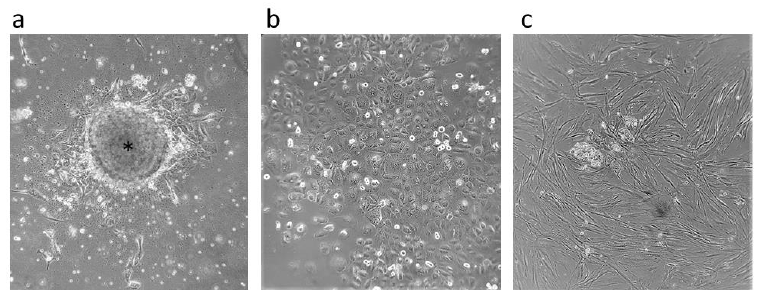
Figure 1. Cell cultures. Primary tumor cells arising from tumor tissue are indicated by an asterisk ( a ) and CD44-positive ( b ) and CD44-negative ( c ) cells after magnetic-activated cell sorting. All microphotographs are at 40× magnification.